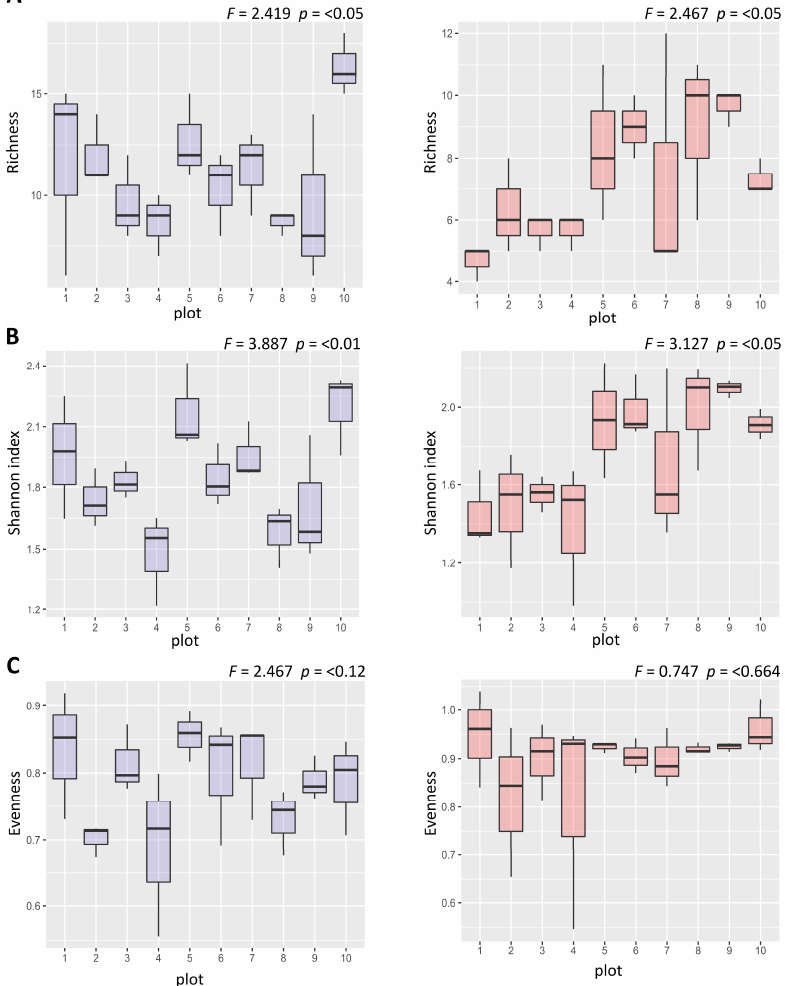
Figure 2. Diversity indices for lichen and lichenicolous fungal communities. In the charts, the boxplot of lichens (violet) and lichenicolous fungi (pink) indices are shown: ( A ) richness values, ( B ) Shannon index, and ( C ) evenness values t. The boxplots represent the first quartile, the median (in bold), and the third quartile. The F statistic and p -value of the ANOVA test are reported on top of each chart. The analyses of β dispersion (the average dissimilarity from individual observation units to their group centroid in multivariate space), showed no significant differences in the dispersion of dissimilarity values neither for the presence/abundance analyses ( F = 3.1832, p > 0.05) nor for abundance ( F = 3.1832, p >